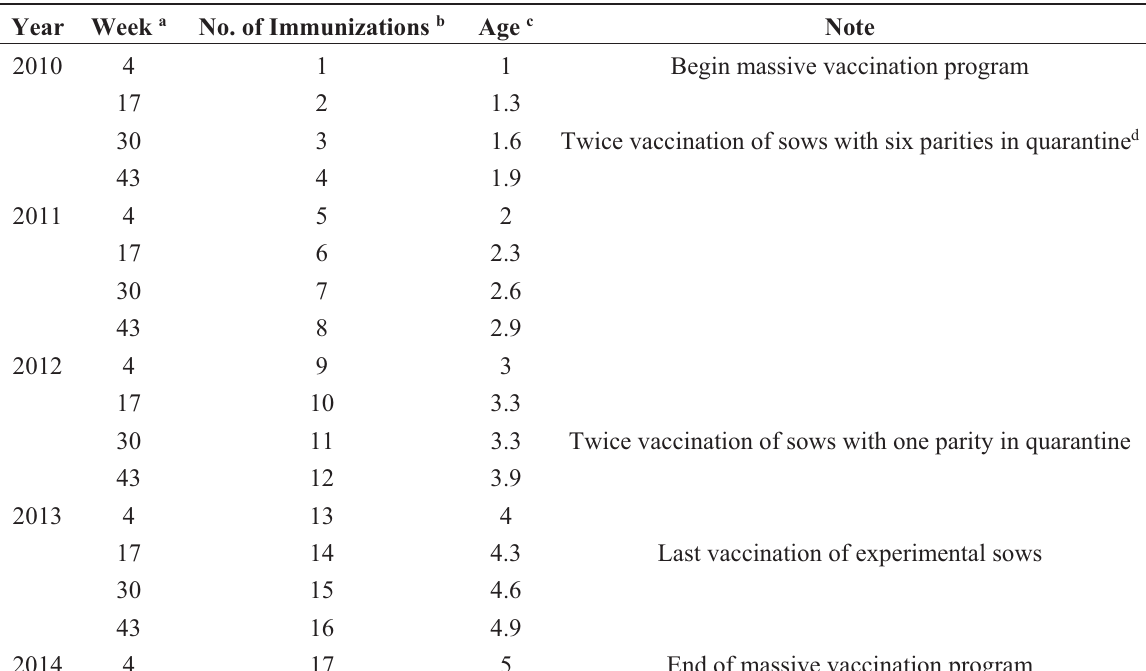
Table 2. Farm vaccination program and estimation of